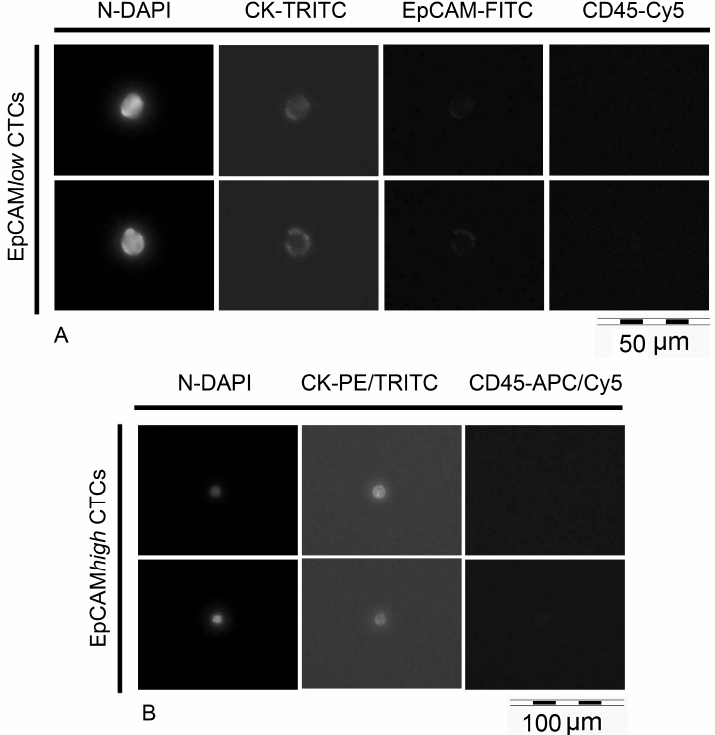
Figure 4. Isolated EpCAM low/negative cells and EpCAM high cells. ( A ) Prior isolation of (epithelial cell adhesion molecule ) EpCAM low/negative cells, selected events were manually scanned at a magnification of 40 × in the following channels: DAPI for nucleic DNA, TRITC for cytokeratins, FITC for EpCAM, Cy5 for CD45. EpCAM low/negative cells show positive staining of nucleic DNA and cytokeratins, very weak or no staining of EpCAM, and no staining of CD45. ( B ) EpCAM high cells enriched in CellSearch ® cartridges were automatically scanned in the abovementioned fluorescent channels, at a magnification of 20 × . They exhibit positive staining of nucleic DNA and cytokeratins, and no signals for CD45. After scanning, single cell isolation was performed in DAPI to assure the absence of contaminations.